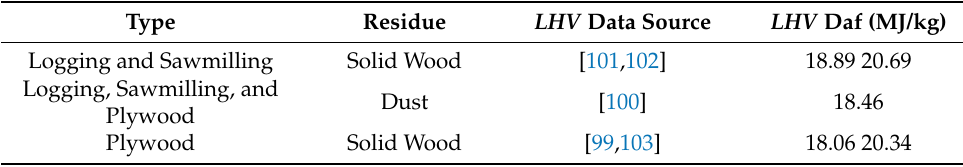
Table A5. Source(s) and data used for the calculation of the forestry